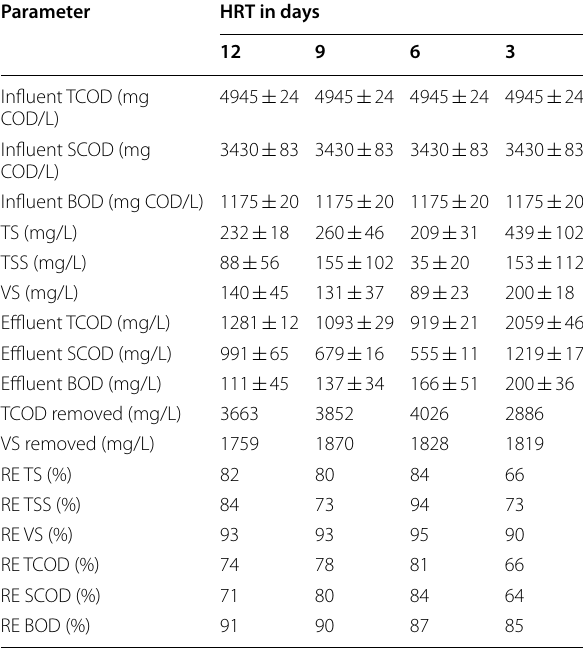
Table 4 Mean values of MR organic matter at all HRT and